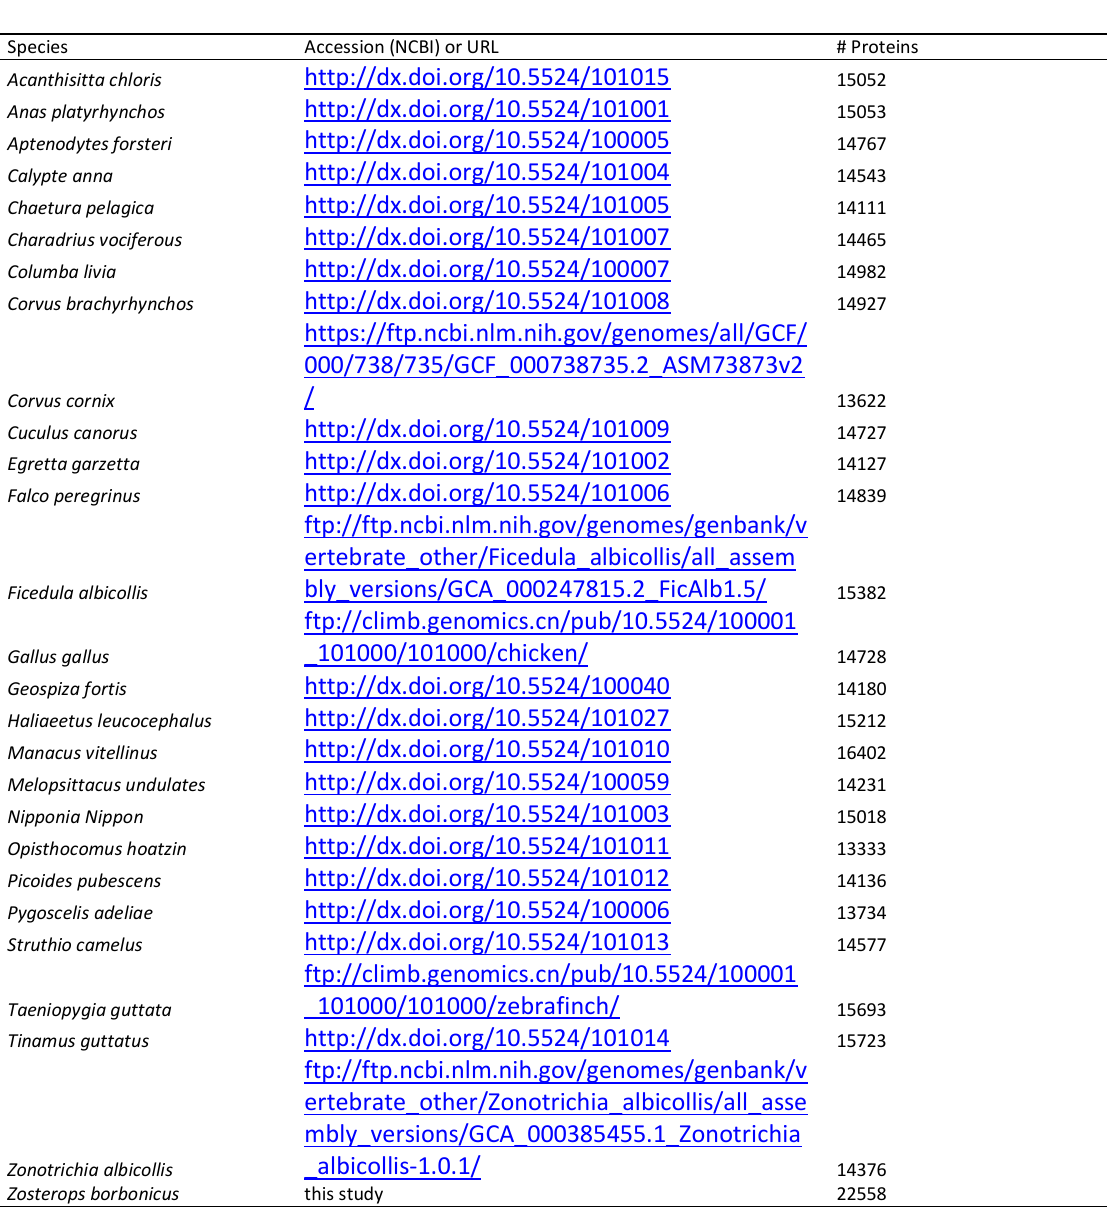
Table S2. List of the 27 avian species used in DeCoSTAR. Number of CDS translated to protein and used for orthology